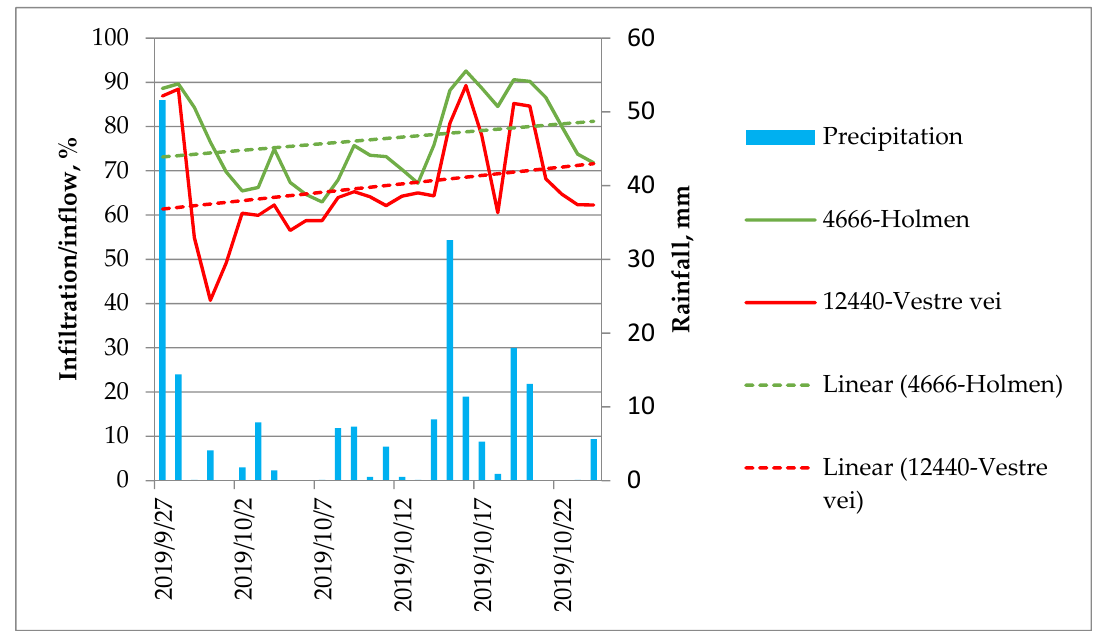
Figure 12. Calculated share of I/I-water during rainfall periods, after the implementation of the measures.